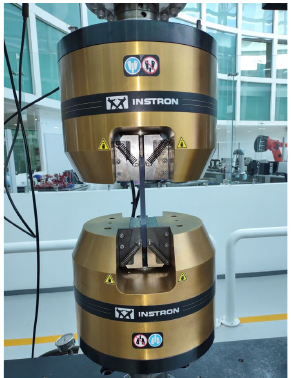
Figure 3. Uniaxial fatigue test.